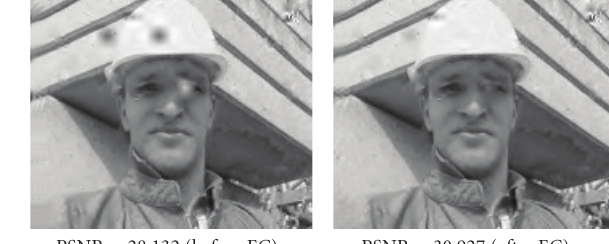
Figure 5: PSNR versus SNR comparison for EEP and UEP schemes.